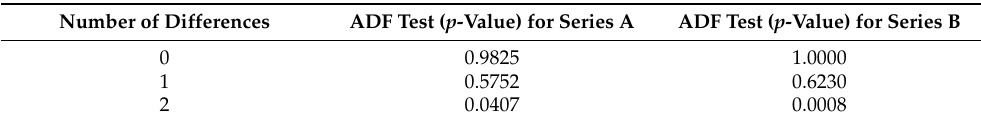
Table 1. The p -values obtained after ADF test, by using square root differences for A. baerii biomass time series data.